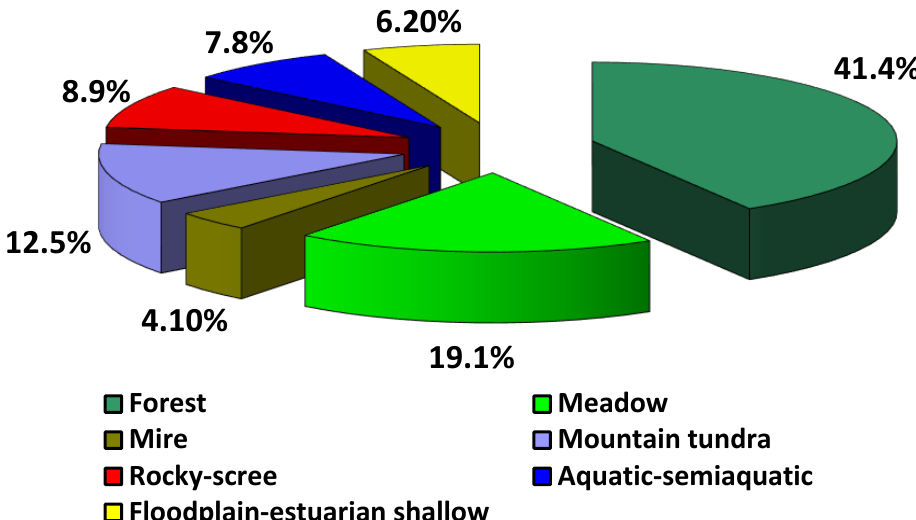
Figure 1. Spectrum of floristic complexes in the Lower Amir region. The core of the forest floristic complex is formed by species whose distribution is associated with East Asia. The primary edificatory plants of these forest formations are represented by plant species of the Far Eastern, Siberian–Far Eastern, and Siberian–Japanese areal groups (see Figure 2): Abies nephrolepis (Trautv.) Maxim., Picea ajanensis Fisch. ex Carri è re, Larix cajanderi Mayr ( Larix gmelinii var. gmelinii (Rupr.) Kuzen.), Pinus koraiensis Siebold et Zucc., Betula costata Trautv., Acer mono Maxim. ( Acer pictum subsp. mono (Maxim.) H. Ohashi), Ulmus japonica (Rehd.) Sarg. ( Ulmus davidiana var. japonica (Rehder) Nakai), Populus suaveolens Fisch ex Poit. et A. Vilm., Fraxinus mandshurica Rupr. and others. Populus tremula L., Duschekia fruticosa (Rupr.) Pouzar ( Alnus alnobetula subsp, fruticosa (Rupr.) Raus), Swida alba (L.) Opiz ( Cornus alba L.), Padus avium Mill. ( Prunus padus L.), Salix bebbiana Sarg. and others are more widely distributed in the forests of the temperate zones of Eurasia and North America. They feature in the formation of secondary groups in habitats that are affected by pyrogenic or other anthropogenic impacts, as well as in intrazonal plant groups on river floodplains. These species include Picea obovata Ledeb. and Pinus sylvestris L., which rarely form independent stands, but often appear as part of dark coniferous fir–spruce and larch